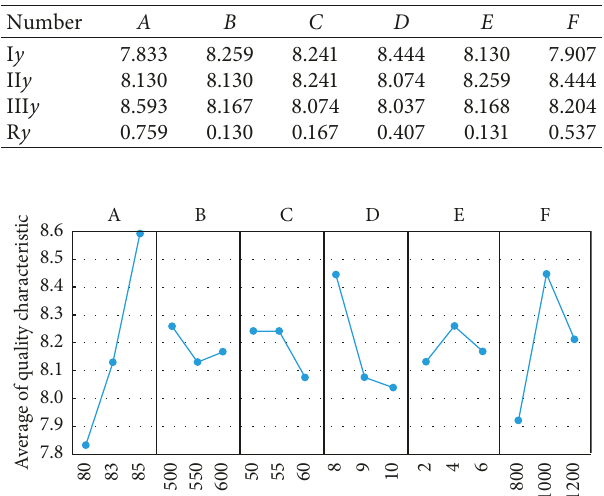
Figure 1: Trend chart of correlation between factors and quality characteristic